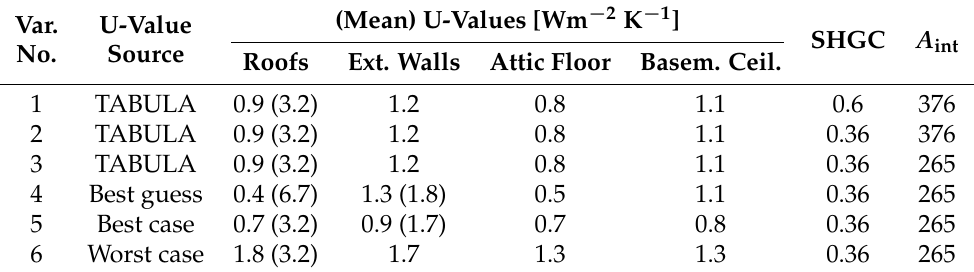
Table 1. Building part heat transfer coefficients (U-values), window solar heat gain coefficients (SHGC) and interior surface areas of different variations of the simulation model for the case study building. Window U-values are always 1.9 Wm − 2 K − 1 . Brackets indicate U-values of envelope components of unheated spaces from which inappropriate insulation layers were